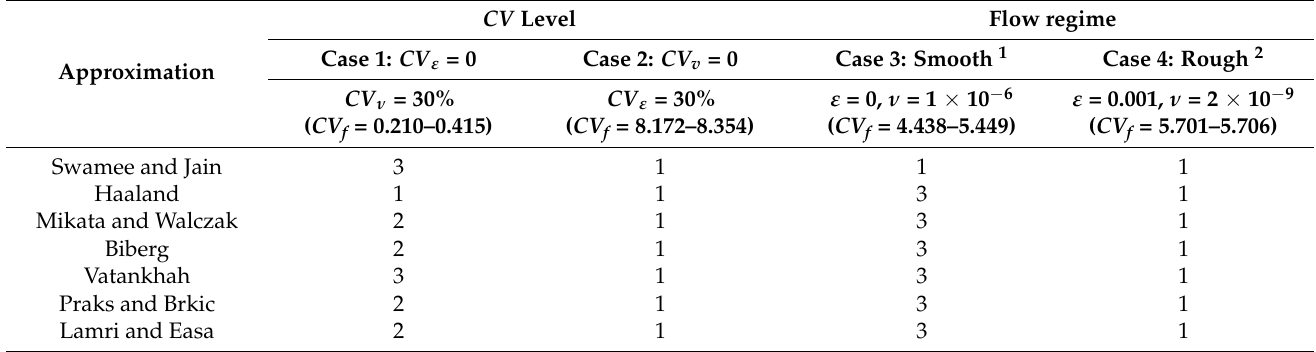
Table 1. Rankings of various approximations based on the reliability